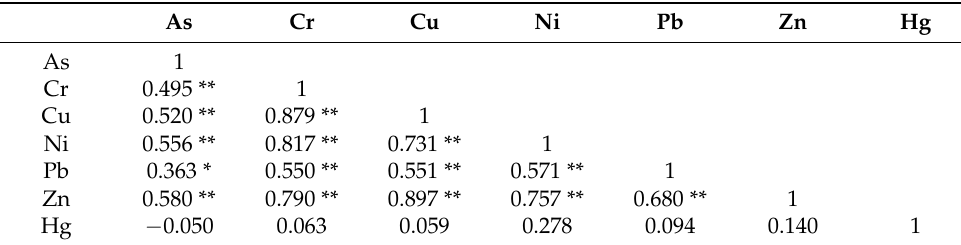
Table 5. The correlation matrix of the analyzed